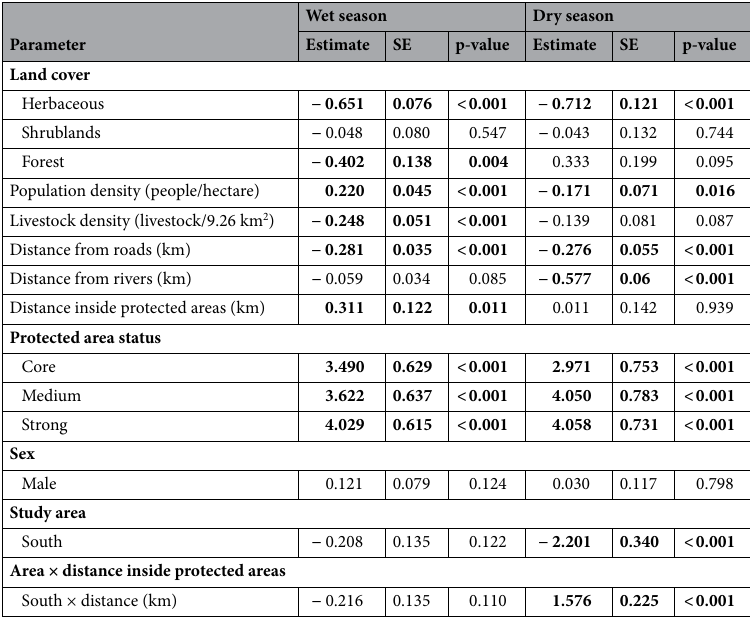
Table 1. Parameter estimates, standard errors (SE), and p-values for lion probability of use during the wet (November–May) and dry (June–October) seasons, Serengeti ecosystem, Tanzania, 2018–2019. Values for categorical variables are as compared to reference categories of cultivated (land cover), no protection (protected area status), female (sex), and the northern study area. Significant predictors (p < 0.05) are marked in